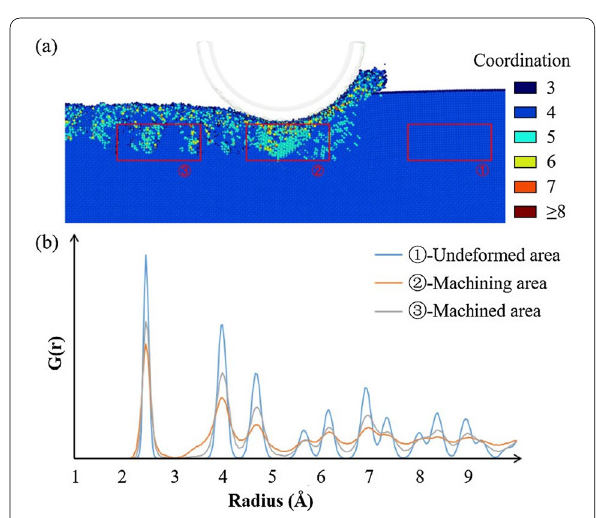
Fig. 10 Selected area radial distribution function: a selected areas; b corresponding radial distribution function